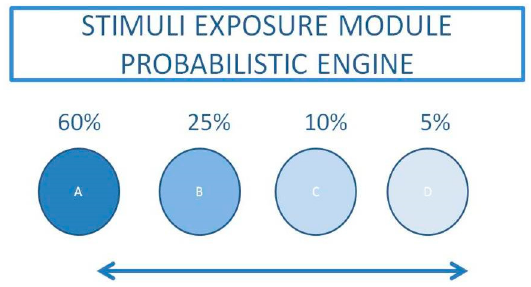
Figure 2. The stimuli exposure module: the probabilistic core for selecting stimuli.